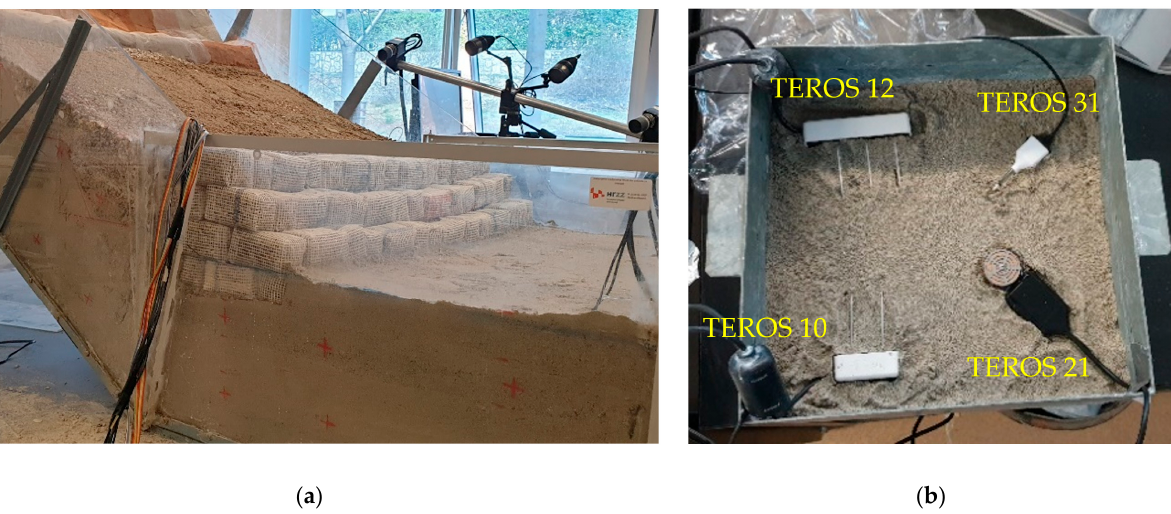
Figure 5. Details on ( a ) model setup with installation of sensors and cameras and ( b ) TEROS 12, 10, 31 and 21 sensors (top and bottom left and right, respectively) for hydraulic monitoring of slope models during the calibration procedure.